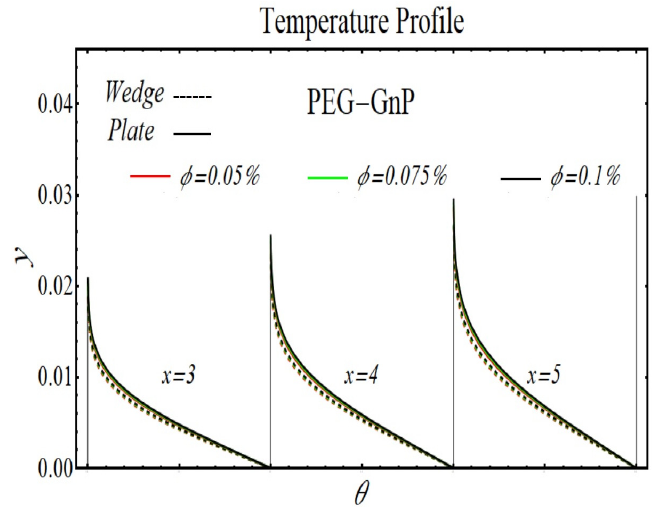
Figure 27. The temperature profile of PEG-GnP/DIW nanofluids over the wedge and plate under the impact of nanoparticle volume fraction.